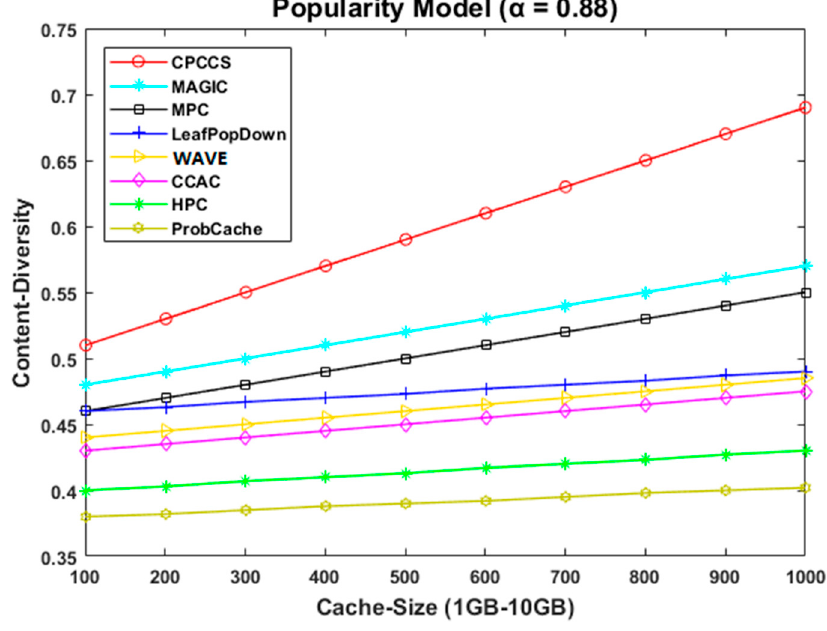
Figure 4. Content diversity with user generated content (UGC).